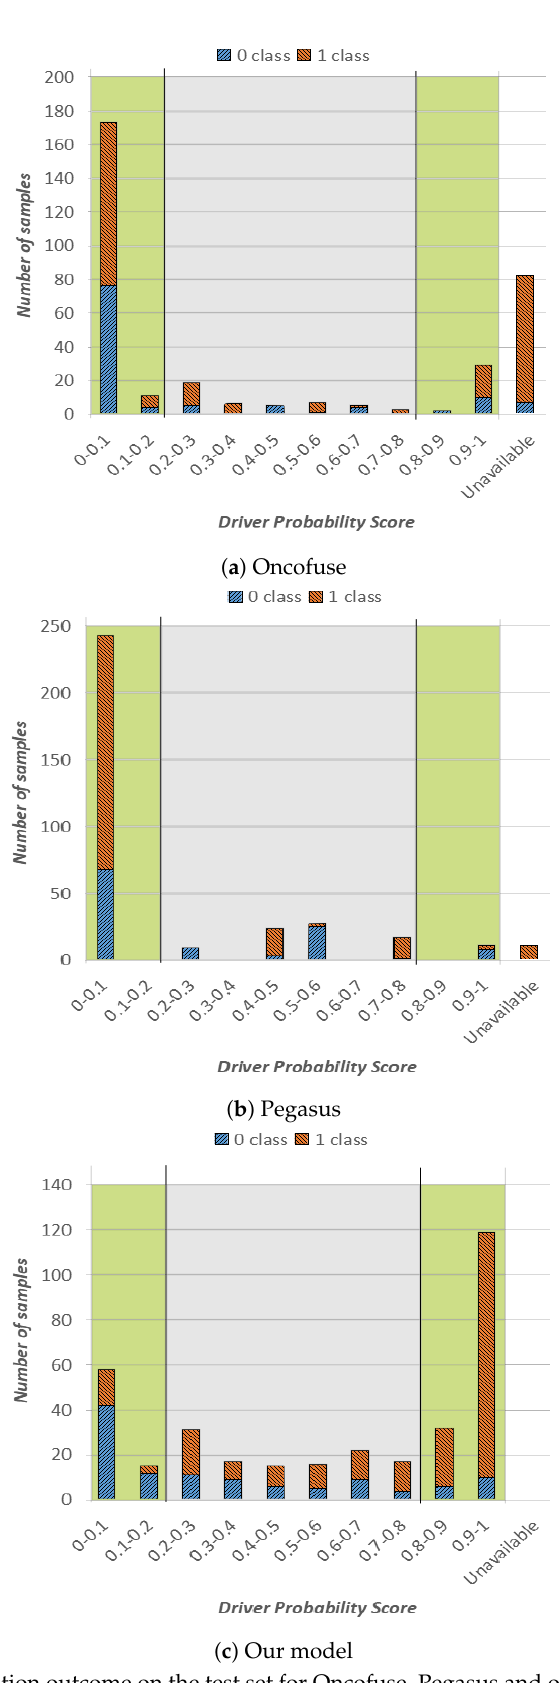
Figure 2. Classification outcome on the test set for Oncofuse, Pegasus and our proposed